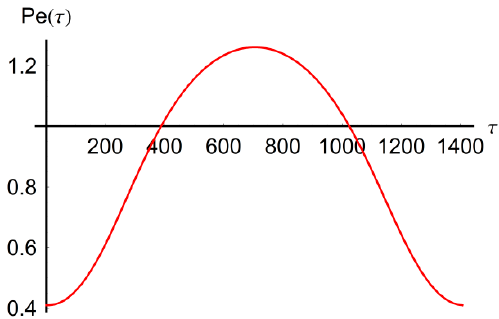
= r ( i 2 + i 2 ) 22 iirPe  . Figure 5. Variation in electrical power during the wind gust Pe l q d qdl